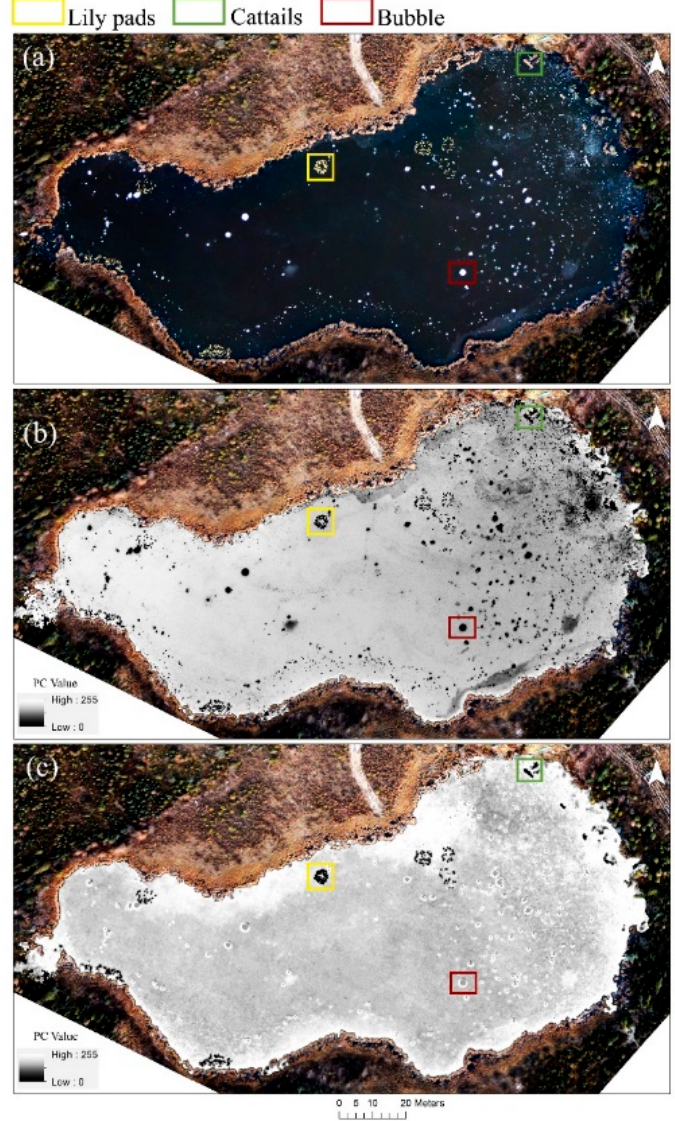
Figure 6. ( a ) True color composite of aerial image of Goldstream Lake (64.91° N, 147.84° W), Fairbanks acquired on 13 October 2012. ( b ) PC 1 band of image shown in ( a ). Bubble patches that appear bright in true color composite in ( a ) have very low gray values in PC 1 band. The area highlighted in red box is an example. Vegetation such as a cluster of lily pad (yellow box) or cattails (green box) also appears dark in PC 1 band. ( c ) PC 2 band of image shown in ( a ). Vegetation is separable from bubble patches. Bubble patches have higher gray values compared to vegetation and appear gray (note: The land area around the lake in ( b ) and ( c ) is shown in the true color composite).